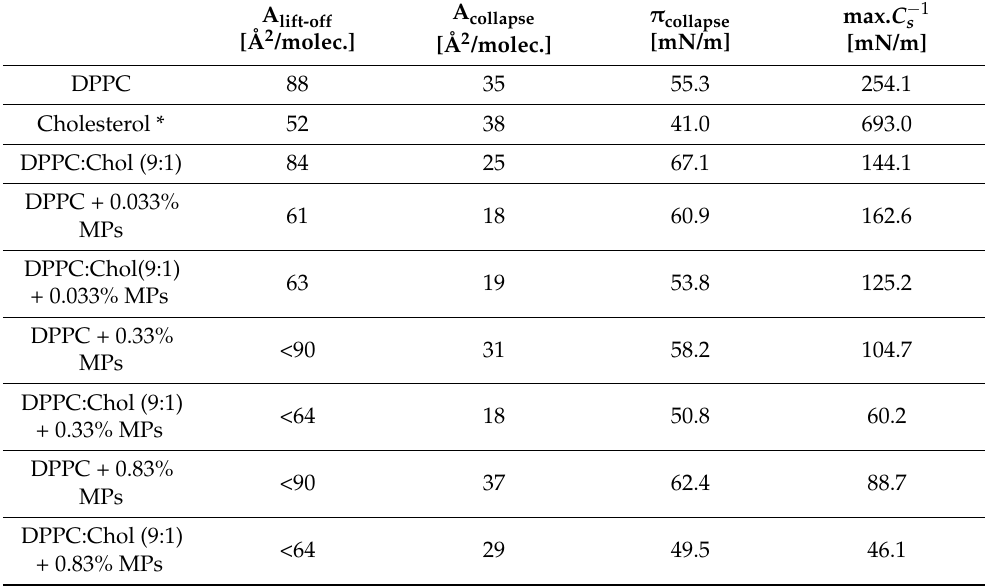
Table 1. Characteristic parameters of π –A isotherms: A lift-off —lift-off area of surface pressure; π collapse —collapse pressure; A collapse —area corresponding to the monolayer collapse; max. C s − 1 —maximum value of the compression modulus. A collapse π A lift-off max. C − 1 s collapse [Å 2 /molec.] [mN/m] [mN/m] [Å 2 /molec.] DPPC 88 35 55.3 254.1 Cholesterol